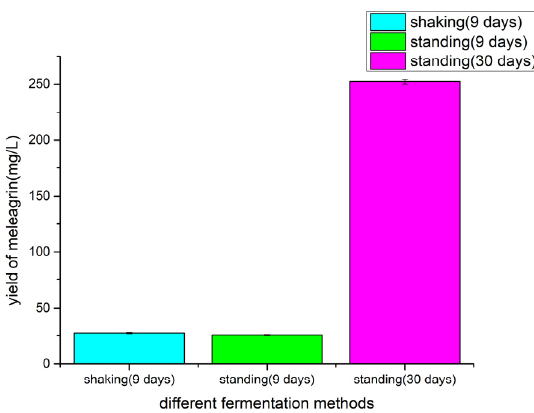
Figure 8. The yield of meleagrin by different fermentation methods.